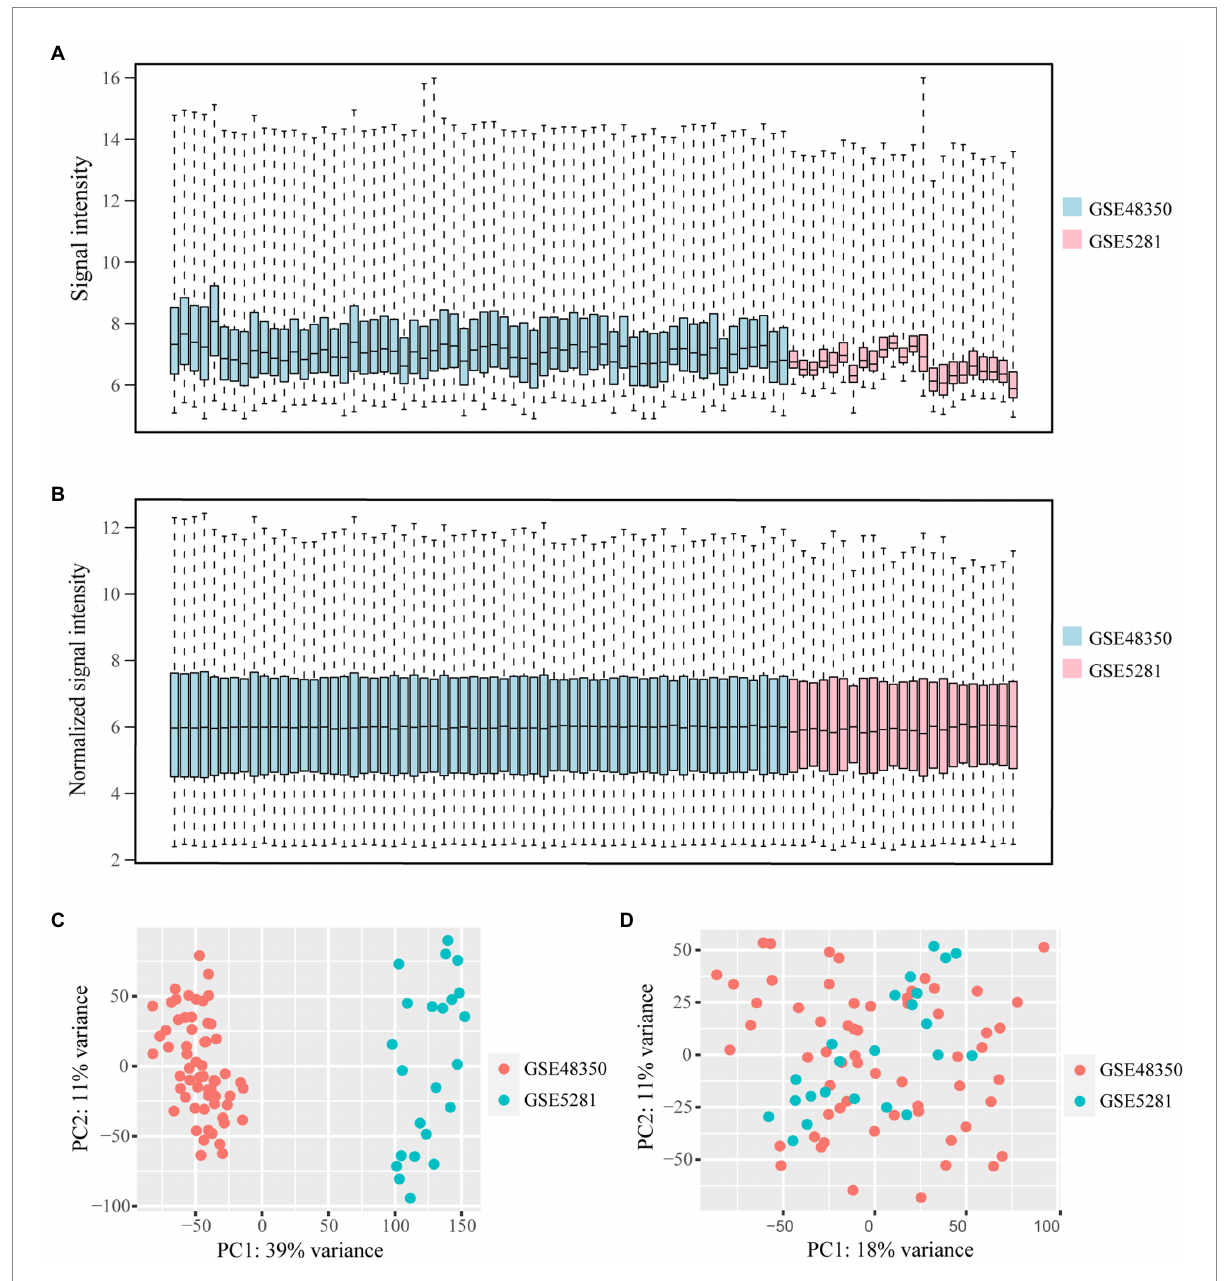
FIGURE 2 Data from GSE483501 and GSE5281 datasets is normalized and the batch effect is removed. (A,B) The box plot of the batch effect of GSE483501 and GSE5281 datasets before and after normalization. The blue boxes represent the signal intensity of the GSE48351 data distribution, the pink boxes represent the signal intensity of the GSE5281 data distribution. (C) Two-dimensional PCA cluster plot of GSE483501 and GSE5281 datasets before batch effect removal. The green dots represent samples from control group. The orange dots represent samples from AD group. (D) Two- dimensional PCA cluster plot of GSE483501 and GSE5281 datasets after batch effect